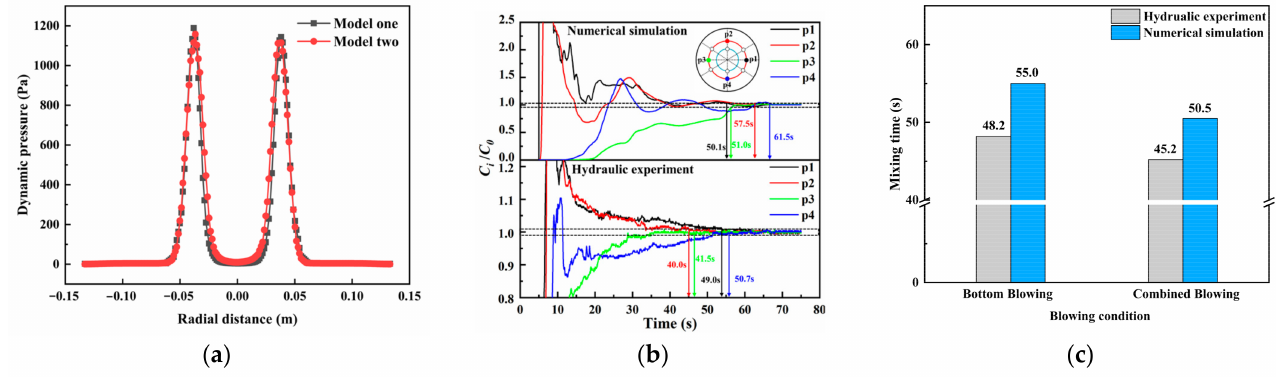
Figure 3. Validation of the model in terms of ( a ) dynamic pressure, ( b ) tracer curve, and ( c ) mixing